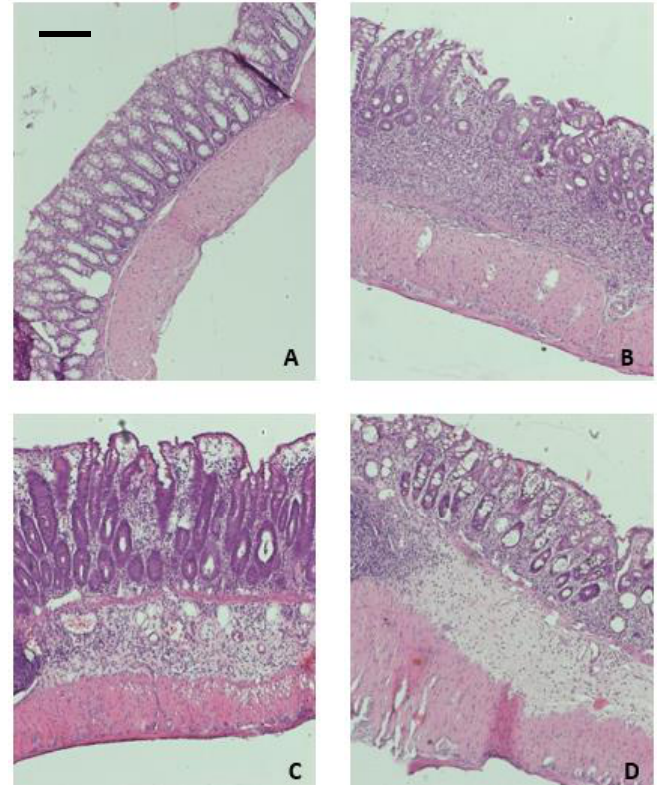
Figure 4. Hematoxylin and eosin staining of mouse colon samples: control ( A ), DSS ( B ), DSS + peptide VII ( C ), and DSS + peptide VIII ( D ). Scale bar = 100 μm.